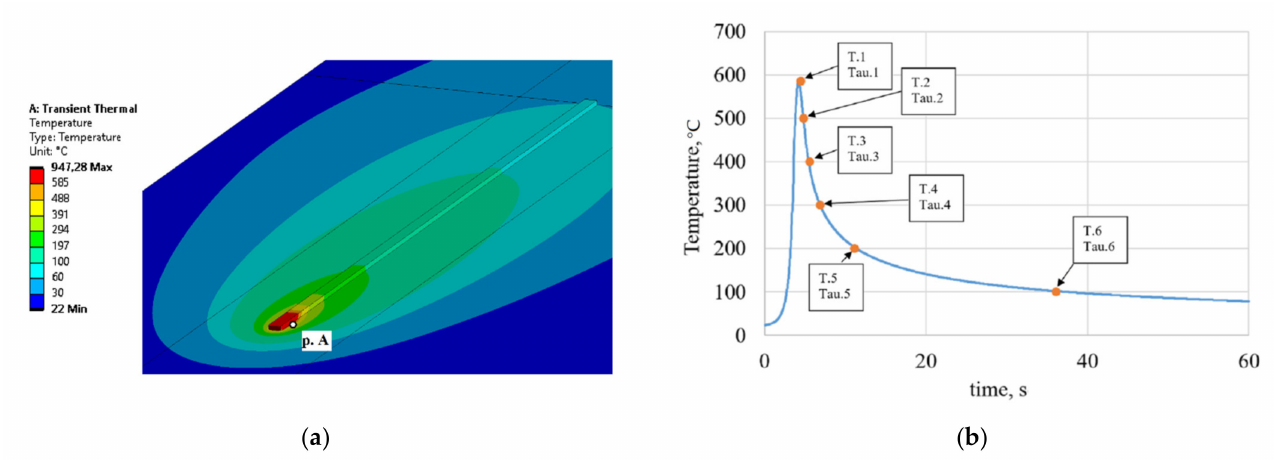
Figure 7. ( a ) Isotherms during deposition (point A–the point on the welding pool boundary); ( b ) thermal cycle of the welding pool boundary for point A.